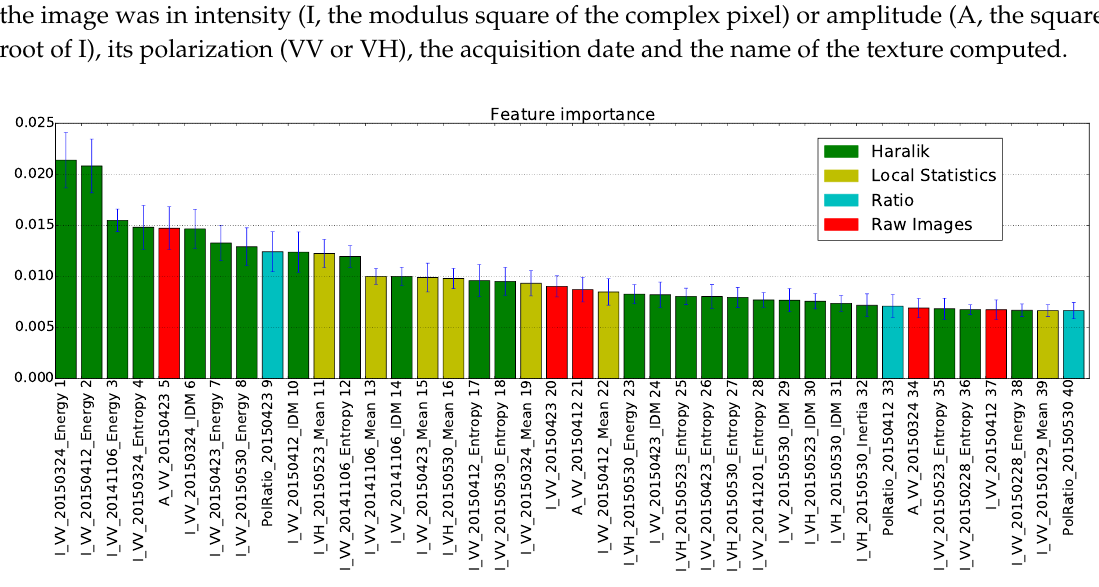
Figure 3. 40 first features sorted by importance. Error bars indicate 95% confidence